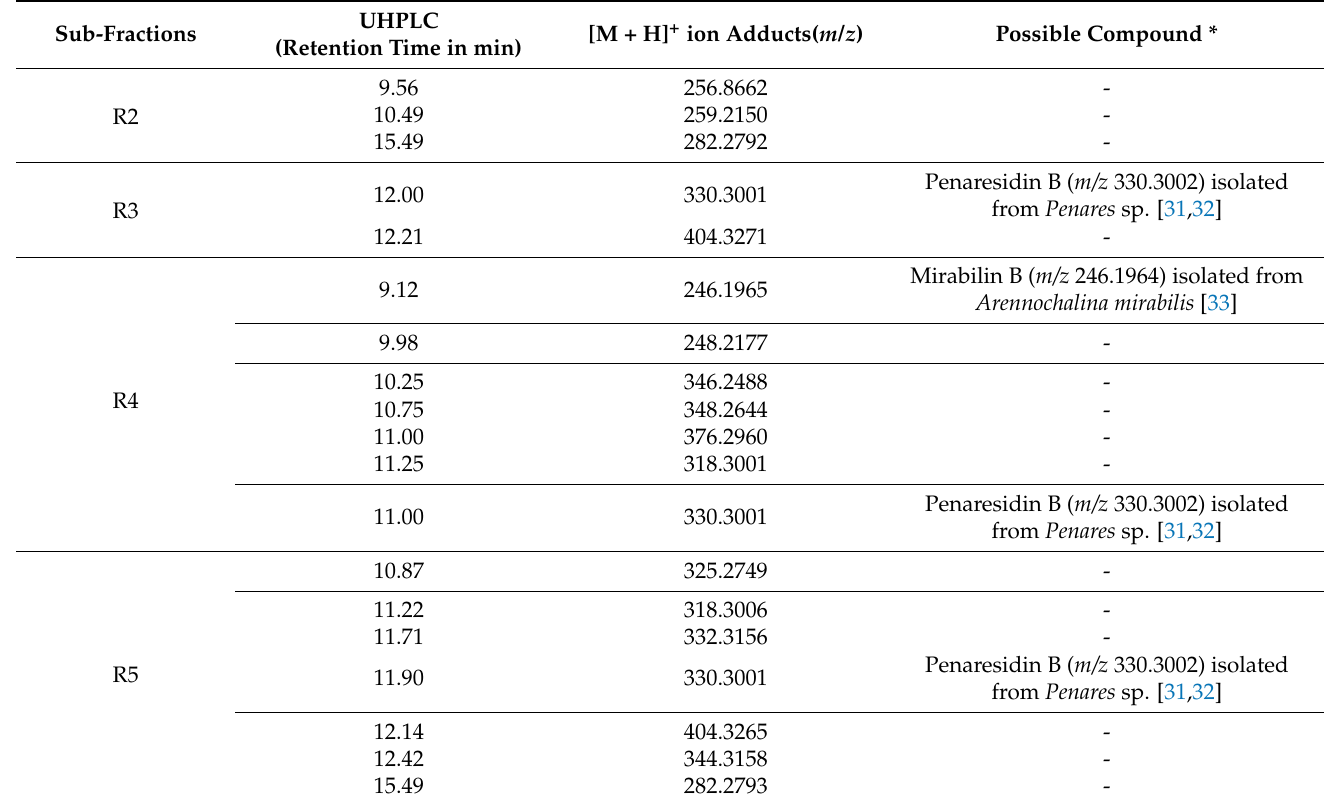
Table 8. [M + H] + ion adducts detected in UHPLC-HRMS analyses of R2, R3, R4 and R5 sub-fractions.